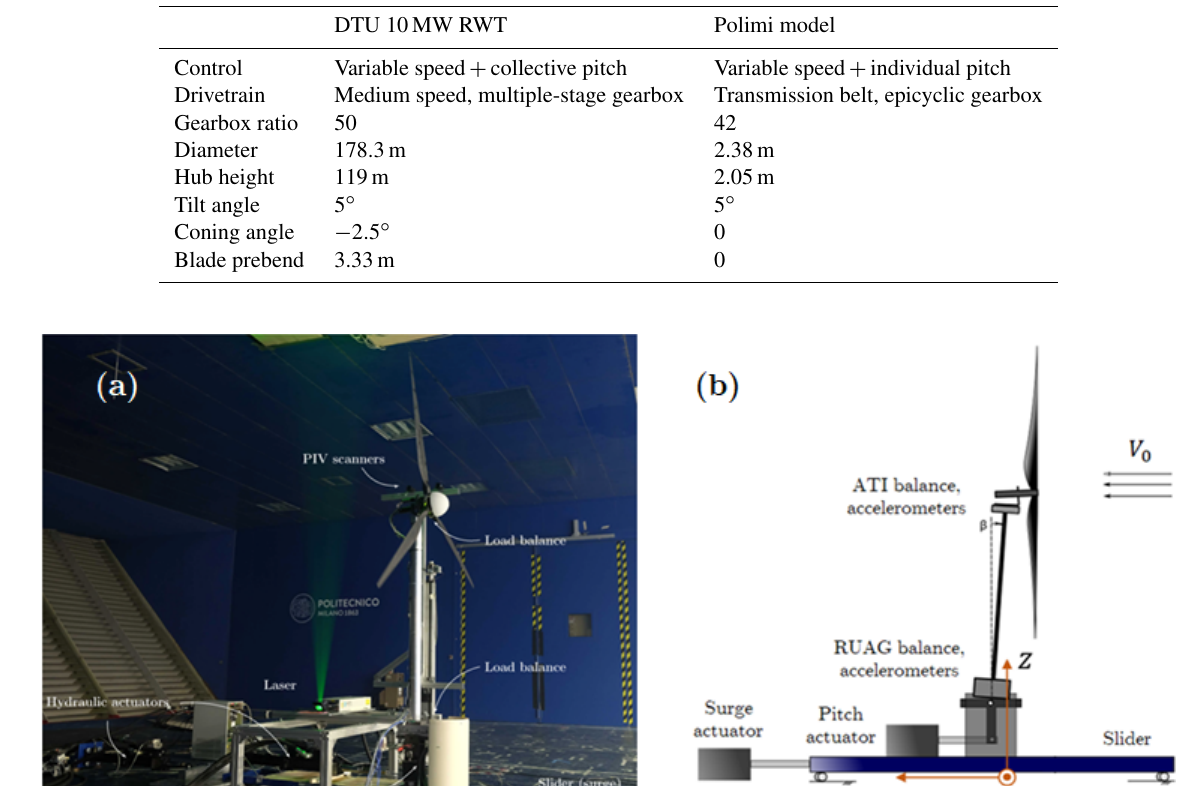
Table 1. Key parameters of the DTU 10MW compared to the Polimi’s model.